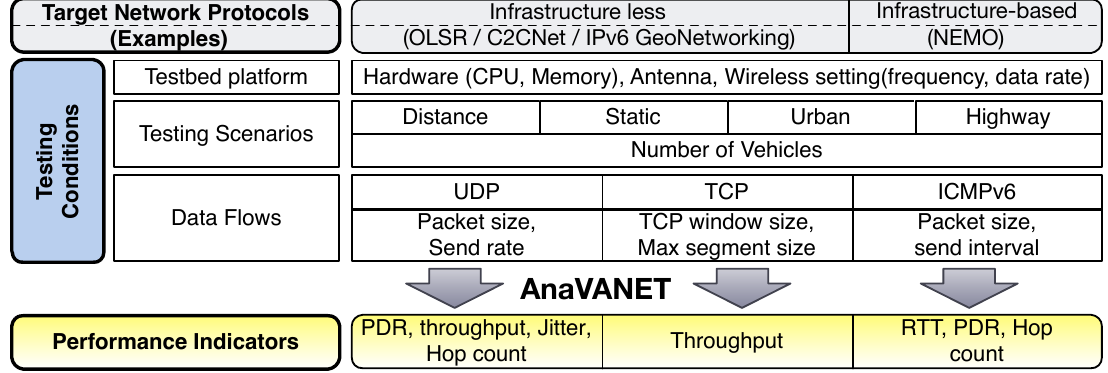
Figure 3. Evaluation methodology